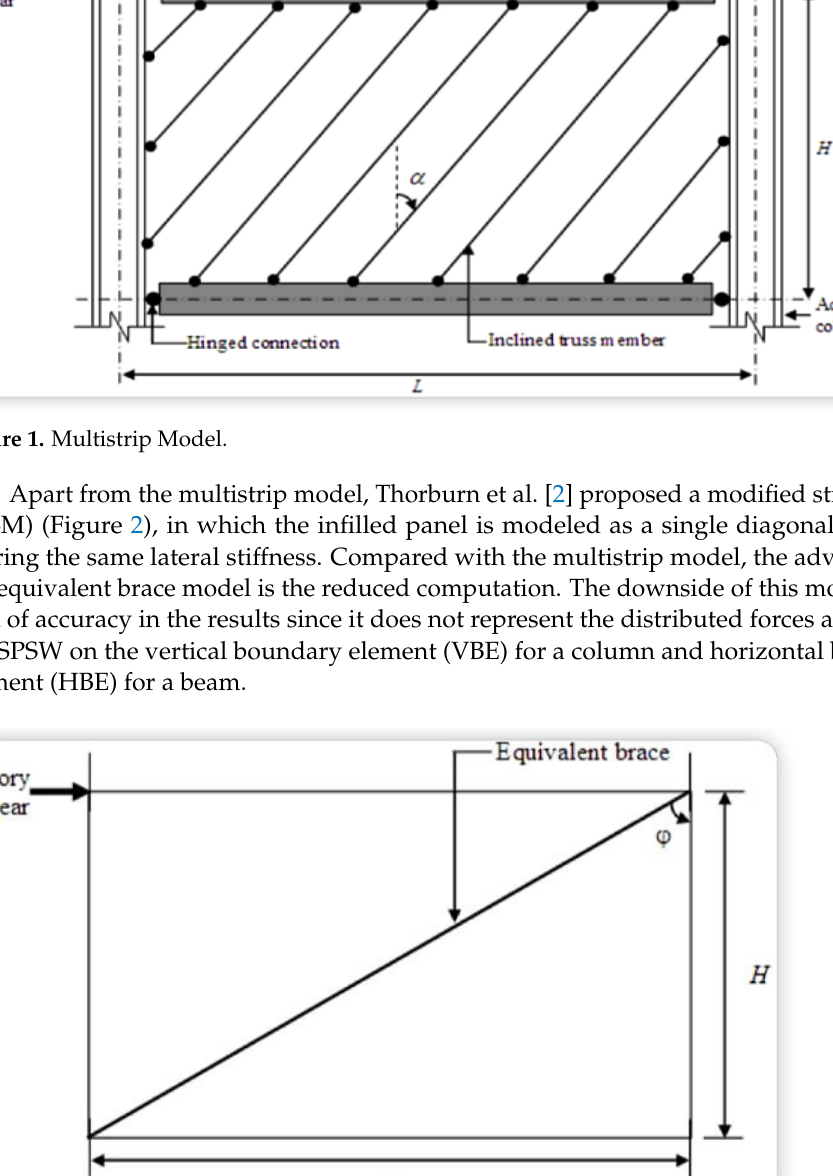
Figure 2. Modified Strip Model.